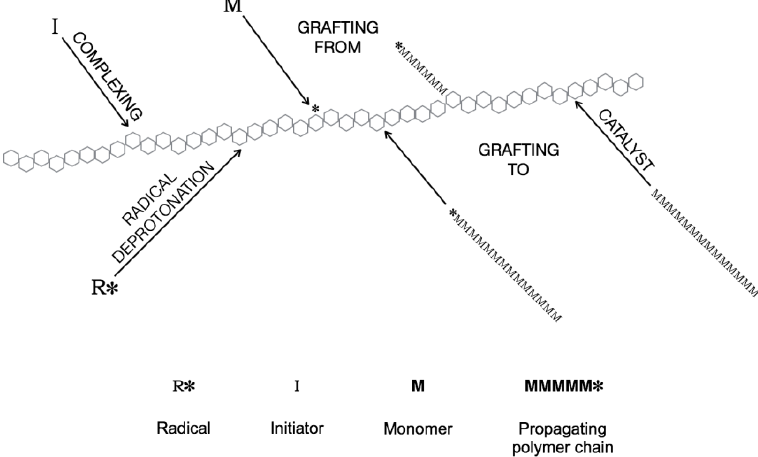
Figure 7. Visualization of the “grafting to” and “grafting from” mechanisms. “Grafting to” occurs when propagating or fully reacted polymer chains bond to the starch chains. “Grafting from” describes initiator complexing or radical deprotonation of the anhydroglucose repeat unit, which creates a radical from which monomer can polymerize.